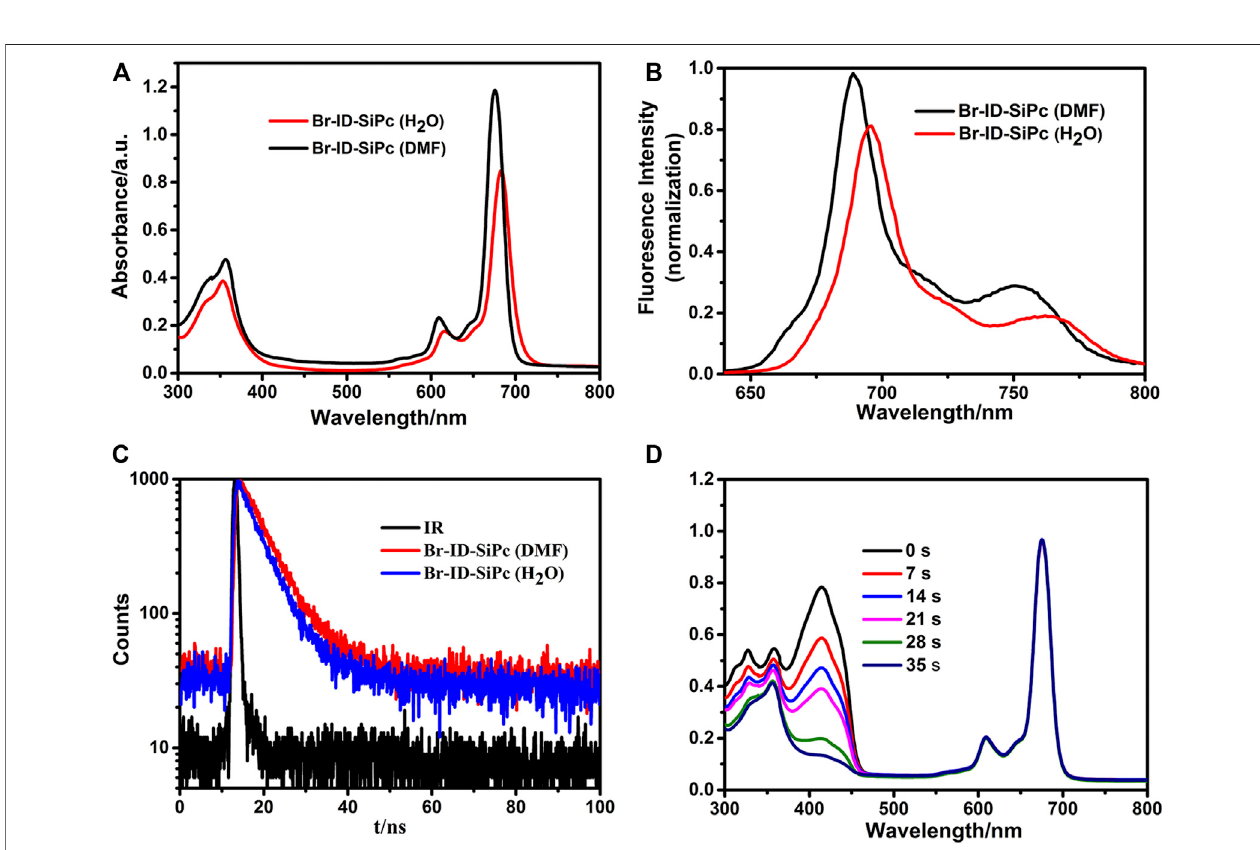
FIGURE 2 | UV/Vis spectra (A) , fl uorescence spectra (B) and fl uorescence decay curves (C) of Br-ID-SiPc in DMF and H 2 O; The spectrum changes during the determinationofsingletoxygenquantumyieldofBr-ID-SiPcinDMF (D) .( (A) : C Br-ID-SiPc =10 μ M; (B) C Br-ID-SiPc =1.0 μ M, λ ex(Br-ID-SiPc) =610 nm; (C) : C Br-ID-SiPc =10 μ M, λ μ ex(Br-ID-SiPc) = 405 nm; (D) : C Br-ID-SiPc = 8